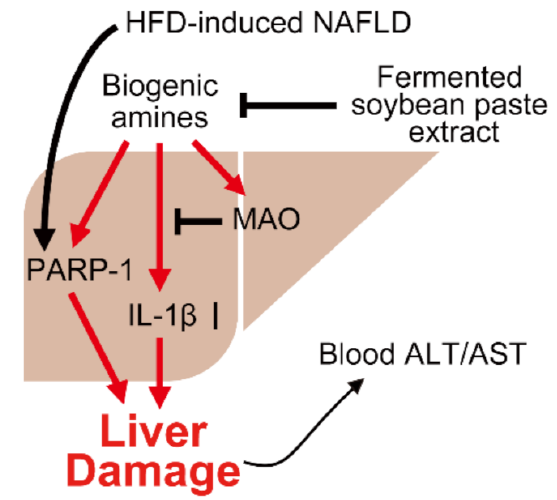
Figure 7. Putative role of fermented soybean paste extract in biogenic amine-induced hepatic damage in NAFLD. A large amount of combined biogenic amine ingestion may exacerbate hepatic function by increasing IL-1 β expression, although activation of MAO degrades biogenic amines in